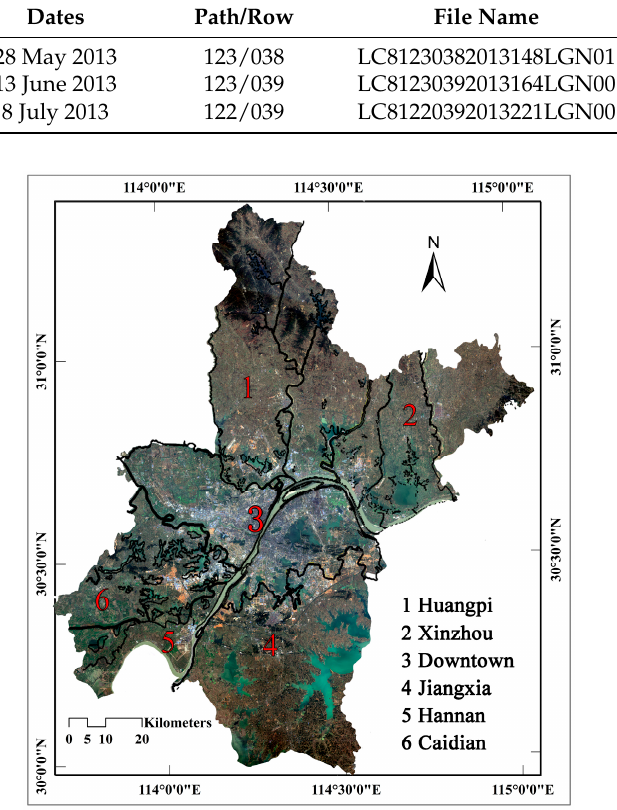
Figure 1. Location of the study area (R: Band4, G: Band3, B: Band2).